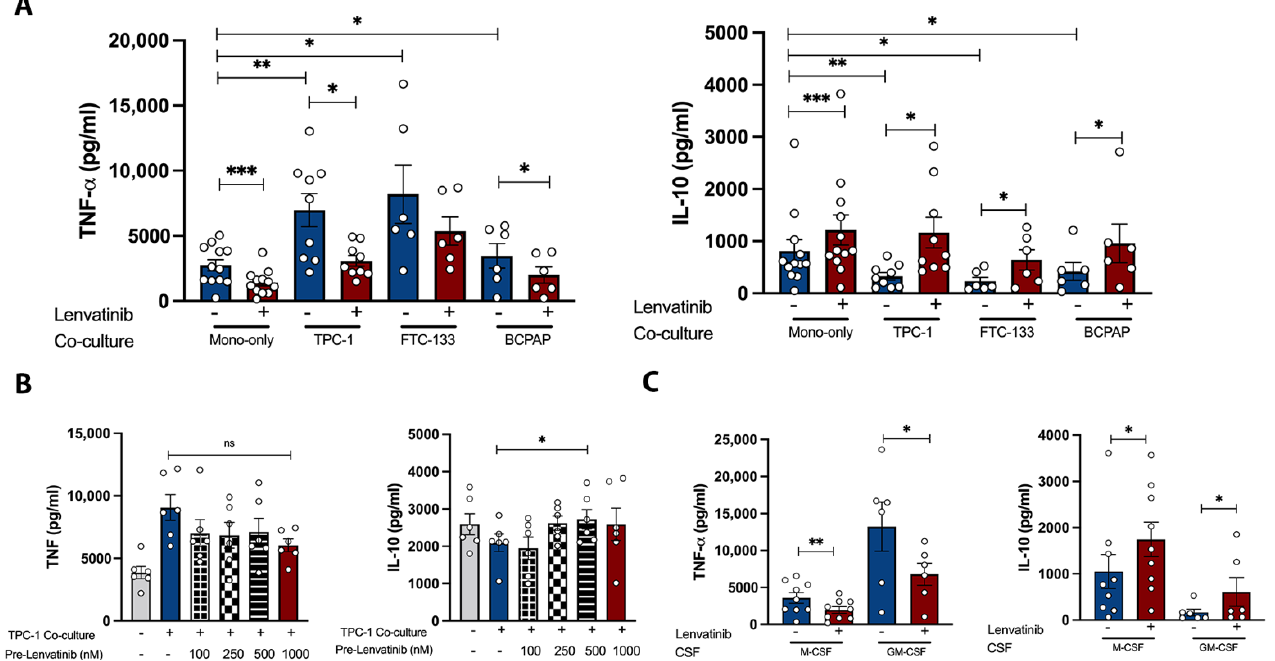
Figure 3. Similar patterns of cytokine production caused by Lenvatinib in different experimental settings. ( A ) In vitro generation of tumor-associated macrophages with 3 TC cell lines. ( B ) Co-cul- ture experiments with TPC-1 cell line pretreated by Lenvatinib for 6 hours. ( C ) Monocytes primed by GM-CSF and M-CSF for 24h, n = 6. The bar graphs indicate mean ± SME; each dot represents one healthy donor. * p <0.05, ** p <0.01, *** p < 0.001 by nonparametric Wilcoxon matched-pair